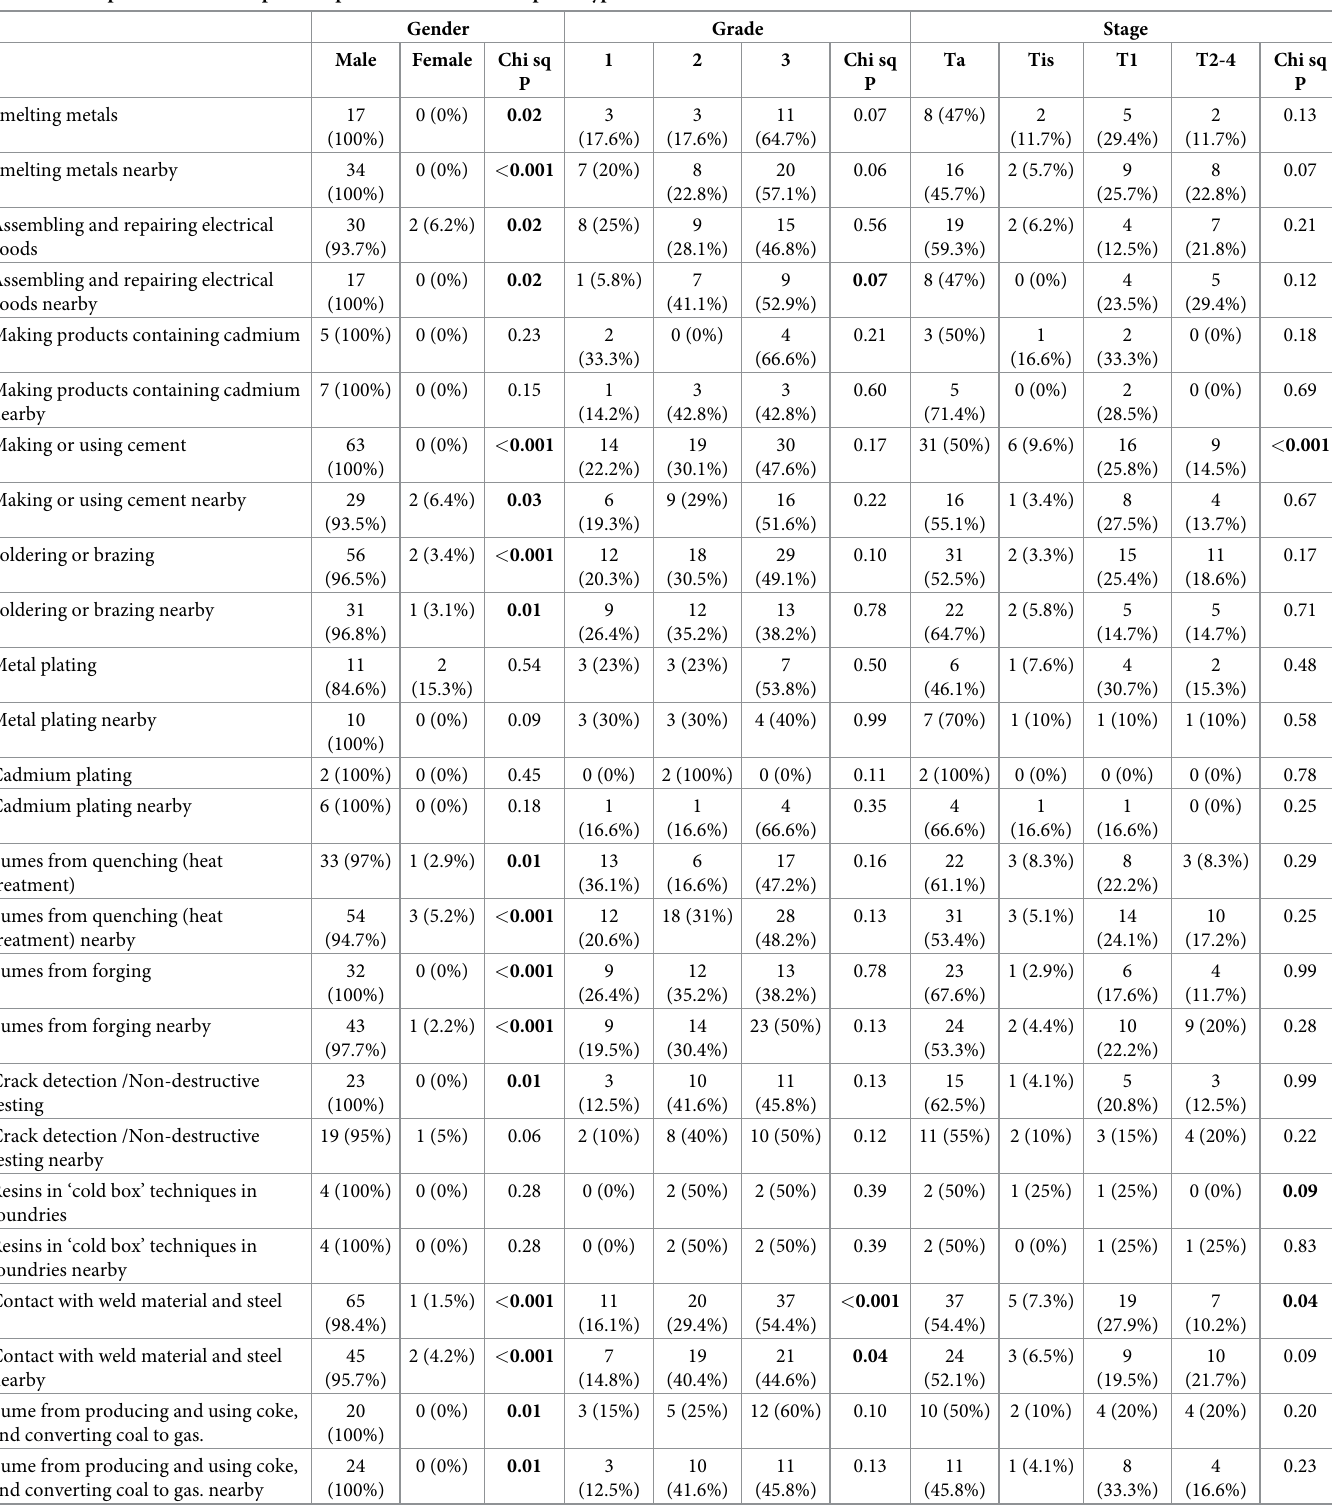
Table 4. Occupational tasks compared to patient sex and tumour